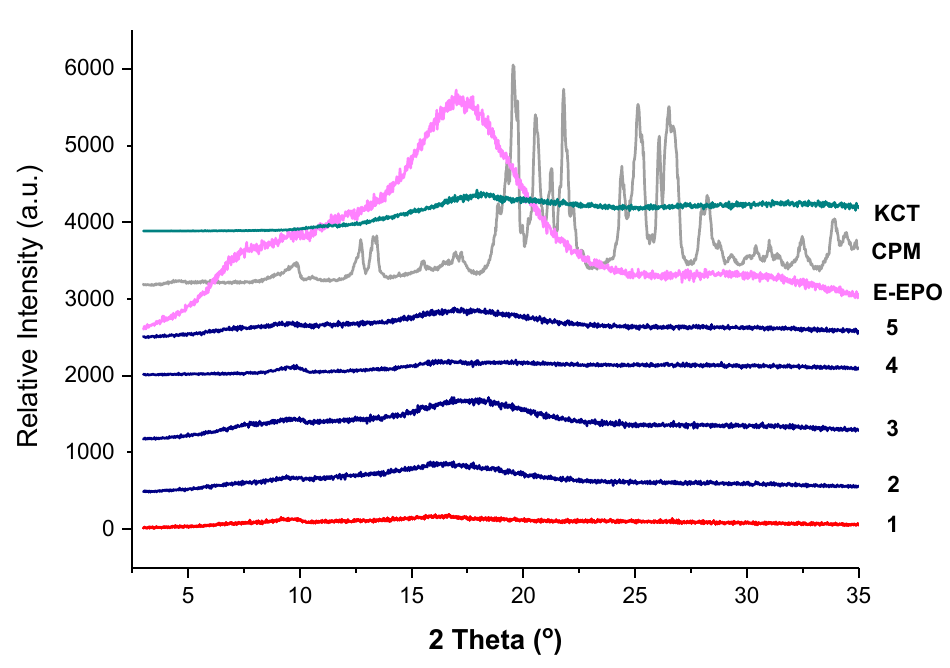
Figure 6. XRD diffraction patterns of pure CPM, E-EPO, KCT and the five co-axial systems electro- spun. The formulations labelled 1 to 5 compositions are as detailed in Table 1.